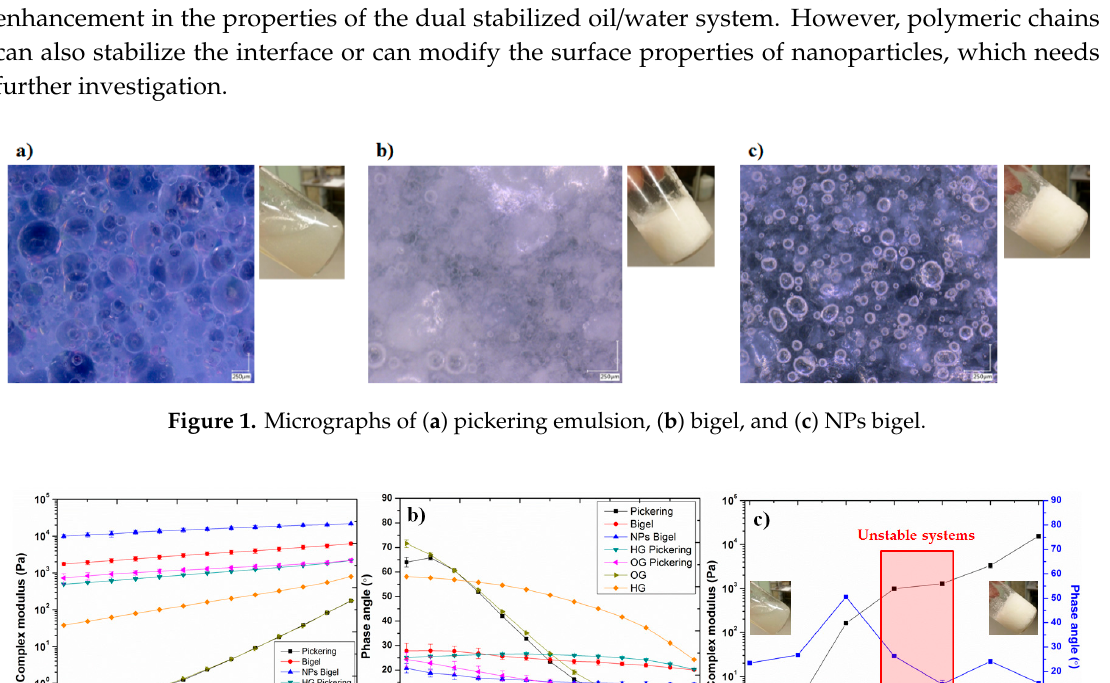
Figure 1. Micrographs of ( a ) pickering emulsion, ( b ) bigel, and ( c ) NPs bigel.